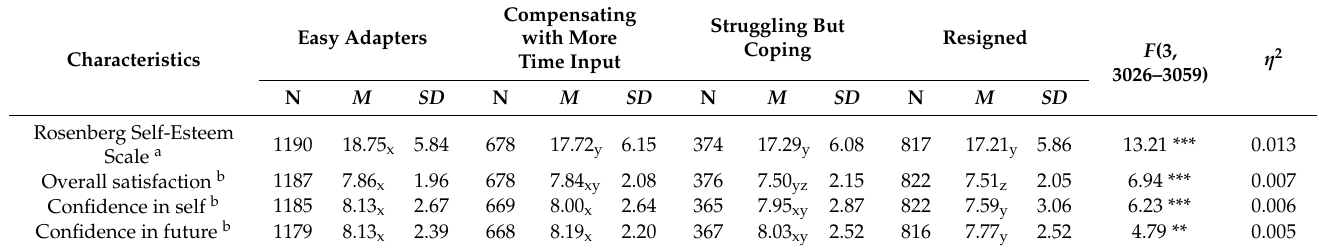
Table 2. Means, standard deviation and one-way ANOVA by individual background